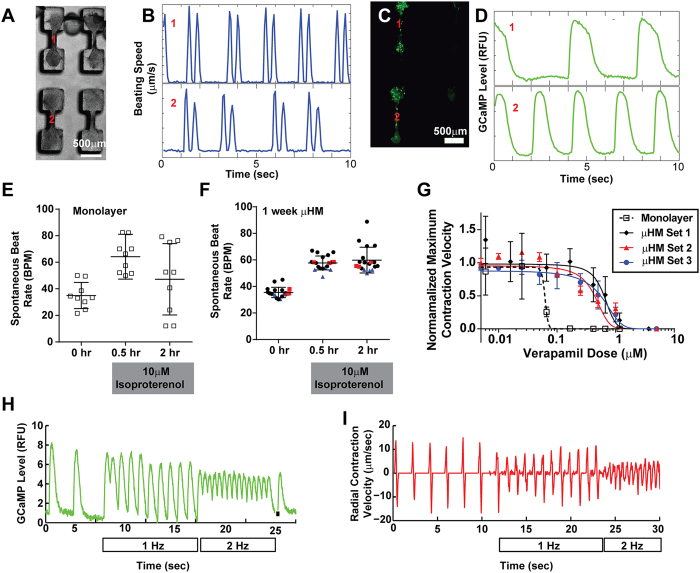
Physiology of iPS-CM within Micro-Heart Muscle Arrays.(A) Representative μHM image; two adjacent μHM are noted as “1” and “2”. (B) Tracings of the root-mean-squared beat speed due to spontaneous contractility the two adjacent μHM, noted in (A). Note tracings indicate that although the μHM have similar rates of beating (a doublet of peaks denotes one contraction-relaxation cycle), they are not beating in a correlated manner. (C,D) Representative (C) image and (D) tracings of calcium flux (GCaMP6 levels) in two adjacent μHM, indicating that the individual tissues have independent calcium flux. (E,F) Chronotropic response to a 10 μM pulse of isoproterenol of iPS-CM co-cultured with isogenic stromal cells within (E) monolayers or (F) μHM arrays. Note μHM arrays formed with different batches of iPS-CM and isogenic EB-stromal cells (derived and purified independently) are colored differently in (F). (G) IC50 analysis for Verapamil, as monitored via contractility (maximum contraction velocity, normalized to maximum contraction velocity in the same tissue before drug treatment), in for iPS-CM and fibroblasts cultured in monolayer (open black squares) or μHM (formed from three different batches of iPS-CM and isogenic EB-stromal cells; solid black diamonds, blue circles and red triangles). (H) Representative tracing of (H) calcium flux (GCaMP6f fluorescence) or (I) radial contraction velocity of the shaft region in 2-week μHM either without field pacing or pacing up to 2 Hz. Note in I, tissue was paced after removing the stencil. Error bars: SEM, n = 5 (monolayer), or 4–10 (μHM).